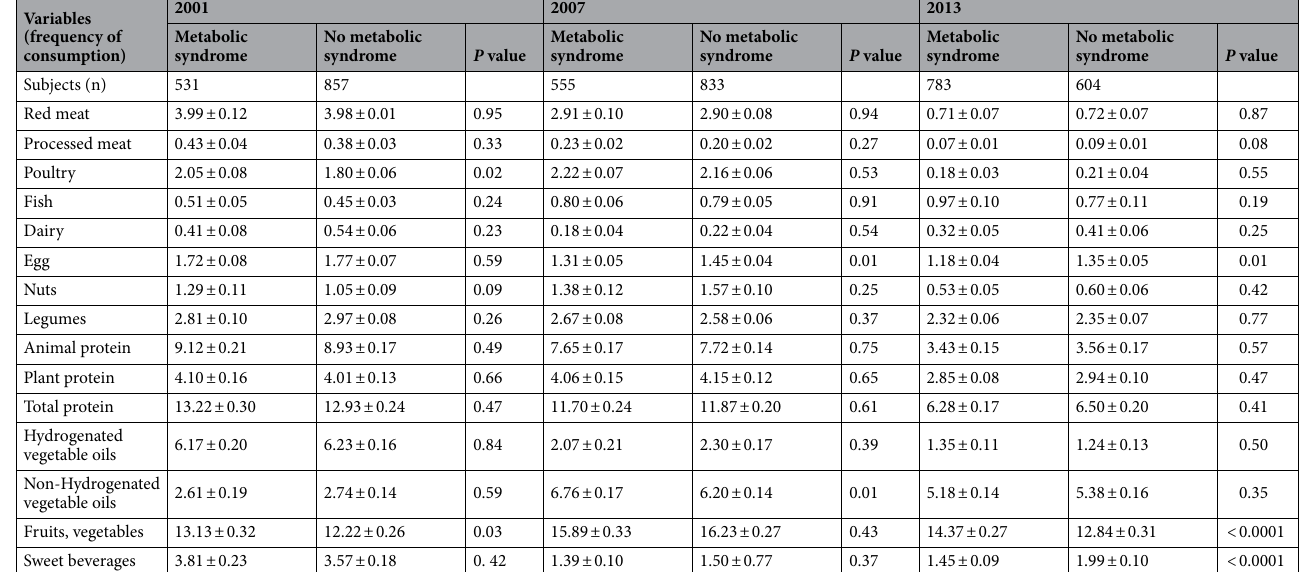
Table 2. Dietary intakes of participants according to the presence or absence of metabolic syndrome. Data are expressed as mean ± SE; all values are adjusted by age and sex (Obtained from ANCOVA).